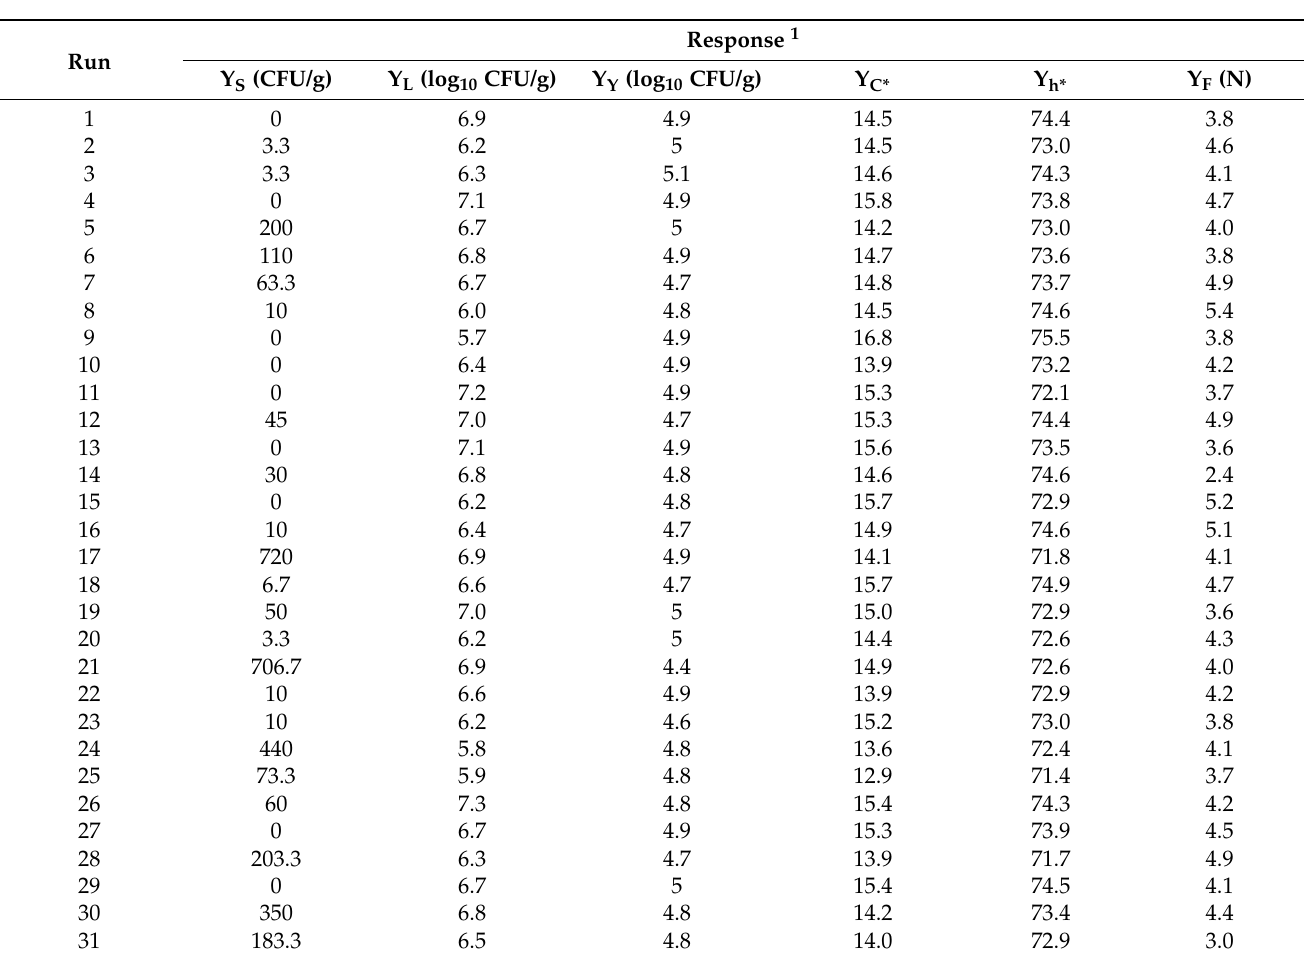
Table 3. Experimental response values for growth of Staphylococcus (Y S ), LAB (Y L ) and yeasts (Y Y ), color (Y C* and Y h* ) and firmness (Y F ).